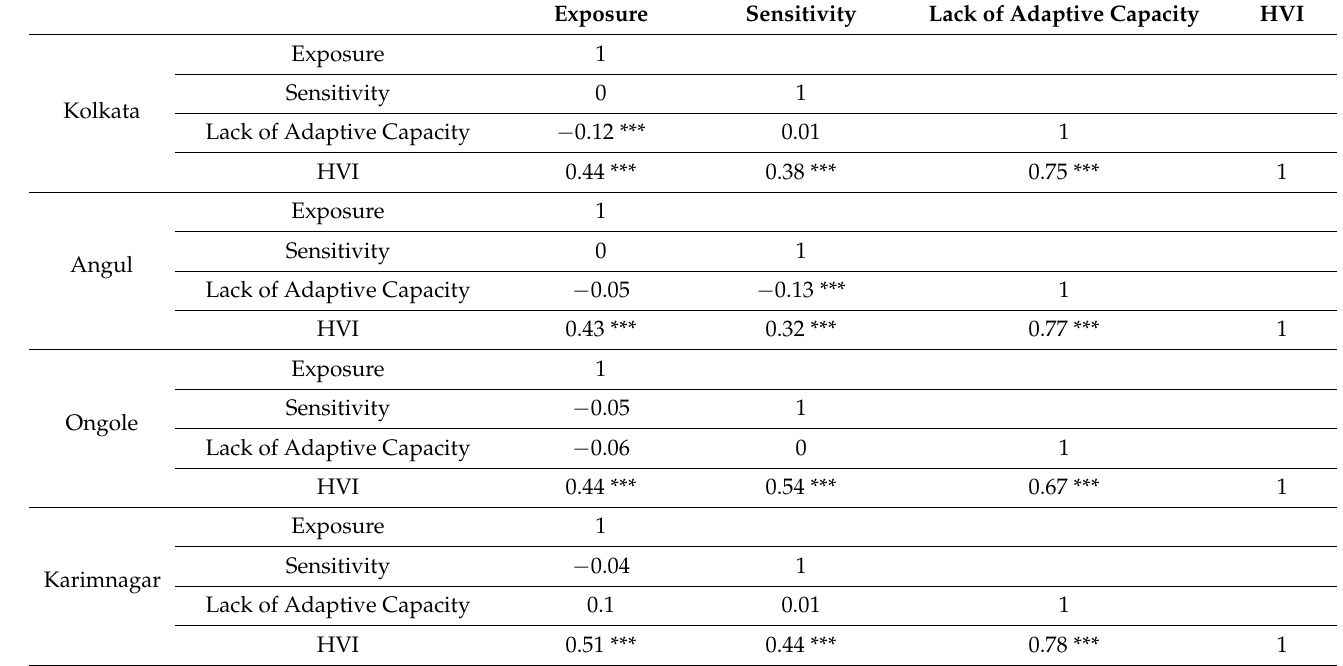
Table 7. Pair-wise Correlation between different Components of